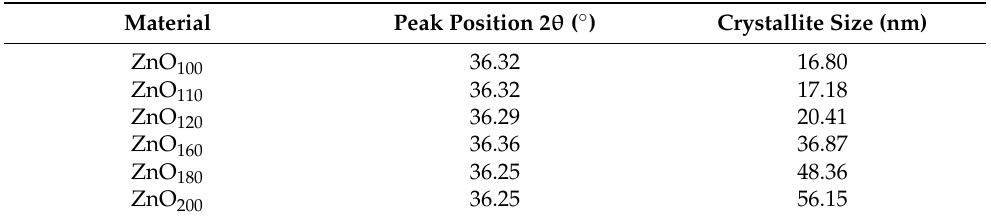
Figure 1. X-ray diffraction patterns of ZnO particles synthesized hydrothermally at 100, 110, 120, 160, 180, and 200 °C. All compared to the ZnO standard, polycrystalline hexagonal wurtzite (JCPDS card No. 36-1451). Table 1. ZnO x crystallite sizes estimated via Scherrer’s equation for the plane (1 0 1). Subscript x corresponds to the temperature (°C) of the hydrothermal synthesis.